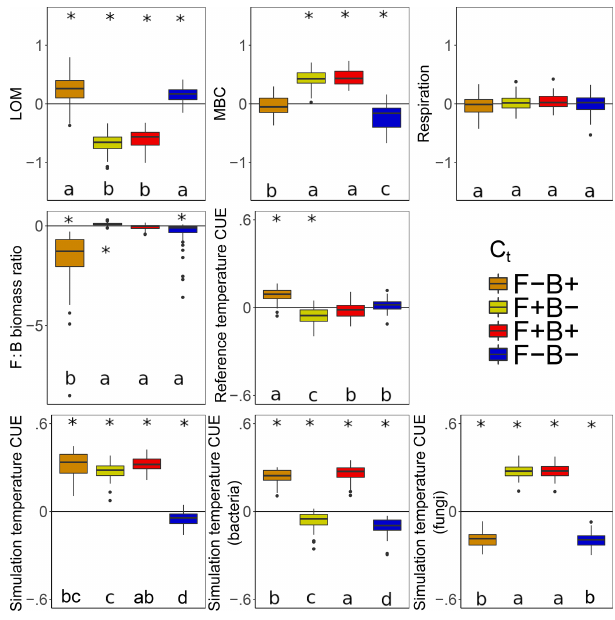
Figure 7. Effect of 5 ◦ C of warming on components of the lit- ter C cycle when bacteria and fungi show dissimilar (F − B + , or- ange; F + B − , yellow) or similar (F + B + , red; F − B − , blue) CUE responses to temperature. Values above the zero line indicate that warming increased the value (log ratio positive), and values below indicate a decrease with warming. Boxplots denote the first to third quartiles with the median. Asterisks denote a significant warming effect at P < 0 . 0001 after correcting for multiple comparisons us- ing the Bonferroni method. Letters denote warmed scenarios which are significantly different from one another using the same criteria. “Reference temperature CUE” denotes the ratio of CUE for the sur- viving community at 15 ◦ C in the warmed scenarios to the ratio of CUE for the surviving community at 15 ◦ in the control scenarios, while “simulation temperature CUE” denotes the ratio of CUE in heated scenarios run at 20 ◦ C to control scenarios run at 15 ◦ C. Val- ues for simulation temperature CUE are also shown for bacteria and fungi